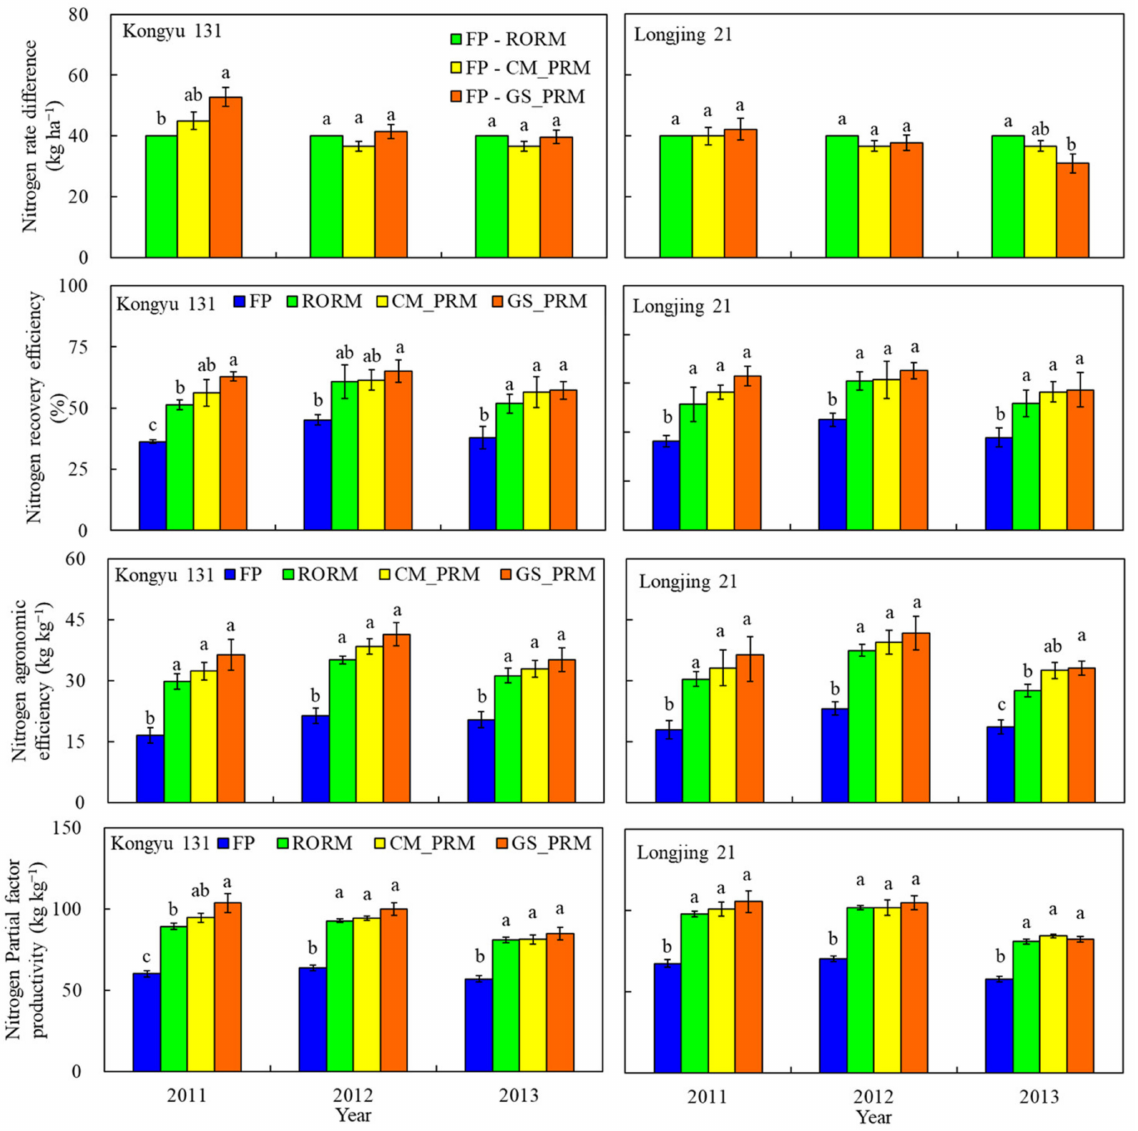
Figure 6. Nitrogen application rates and nitrogen use efficiency parameters of different rice man- agement systems of two rice varieties, Kongyu 131 ( left ) and Longjing 21 ( right ), from 2011–2013. CK, FP, RORM, CM_PRM, and GS_PRM represent check, farmer’s practice, regional optimum rice management, chlorophyll meter-based precision rice management, and GreenSeeker sensor-based precision rice management, respectively. Different letters indicate significant differences at p < 0.05 level in the same year. The error bars indicate standard deviations. There are no error bars for nitrogen rate difference between FP and RORM (FP-RORM), because there was no change in the amount of nitrogen applied in the FP and RORM systems from 2011 to